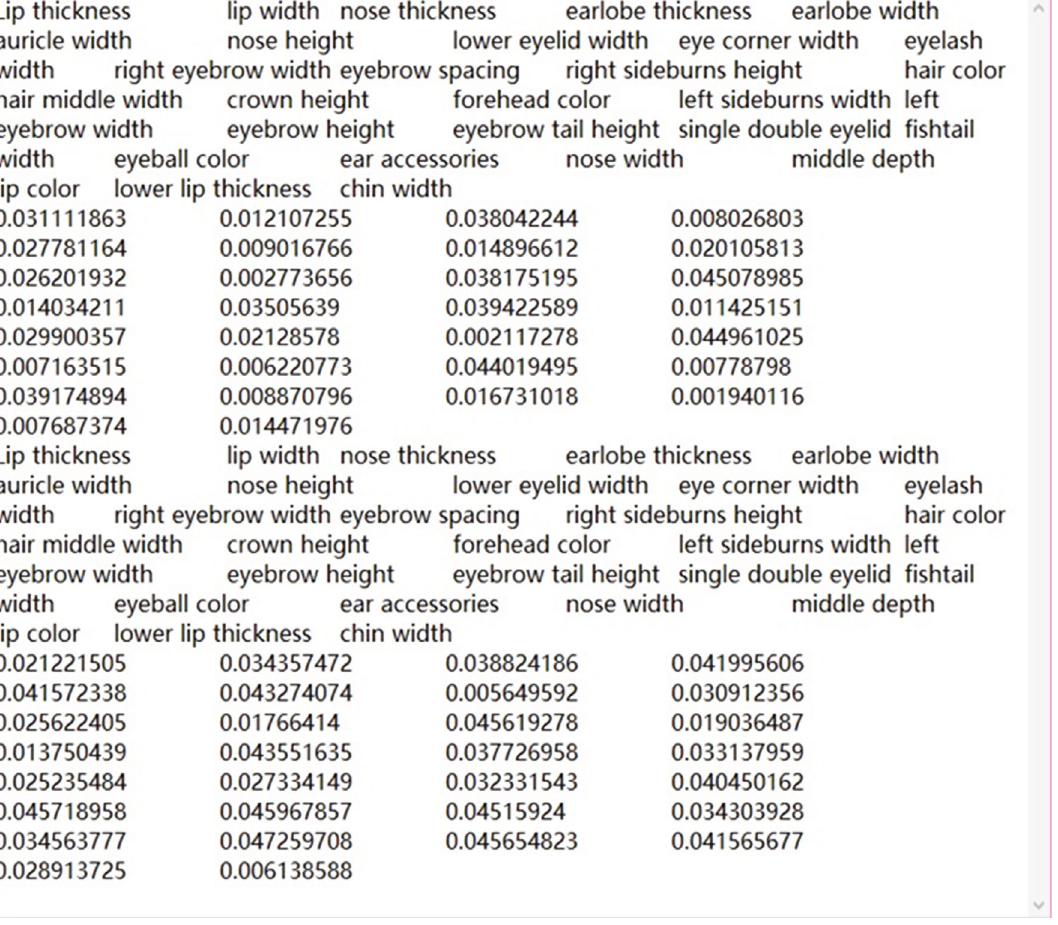
Figure 7: The details of